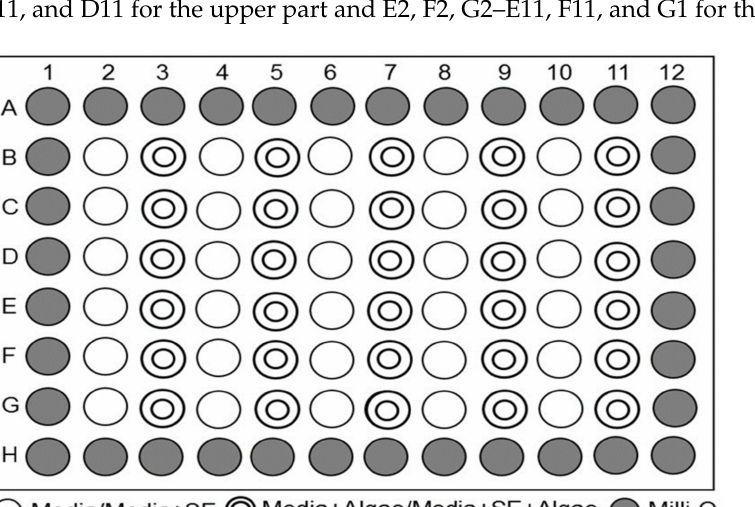
Figure 7. Microplate incubation